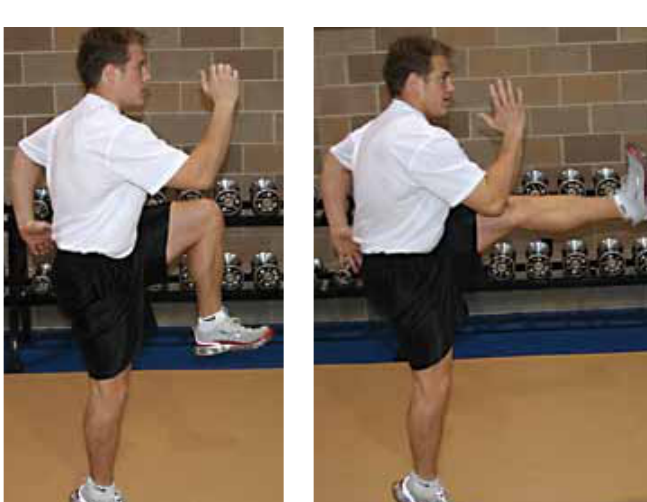
Figure 5-11b. Knee ExtensionFigure 5-11a. Driving the